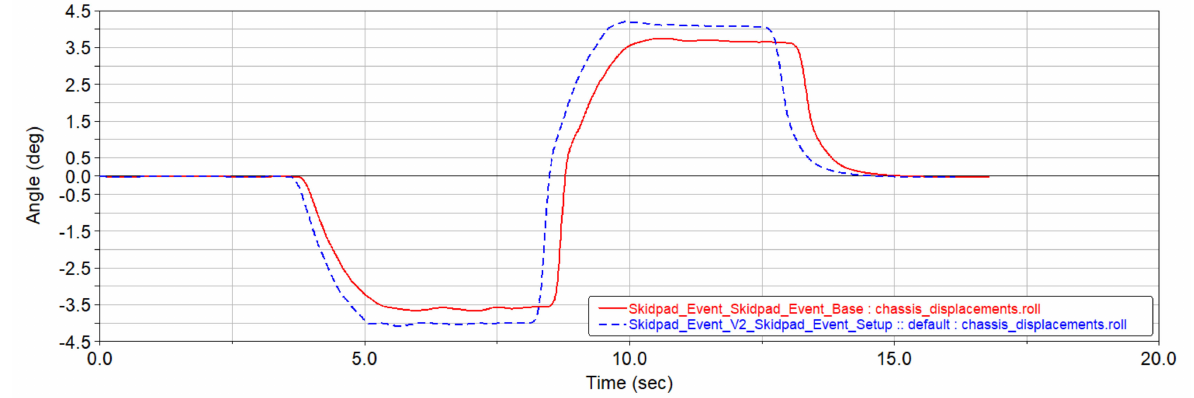
Figure 21. Skidpad Event-Roll angle comparison.